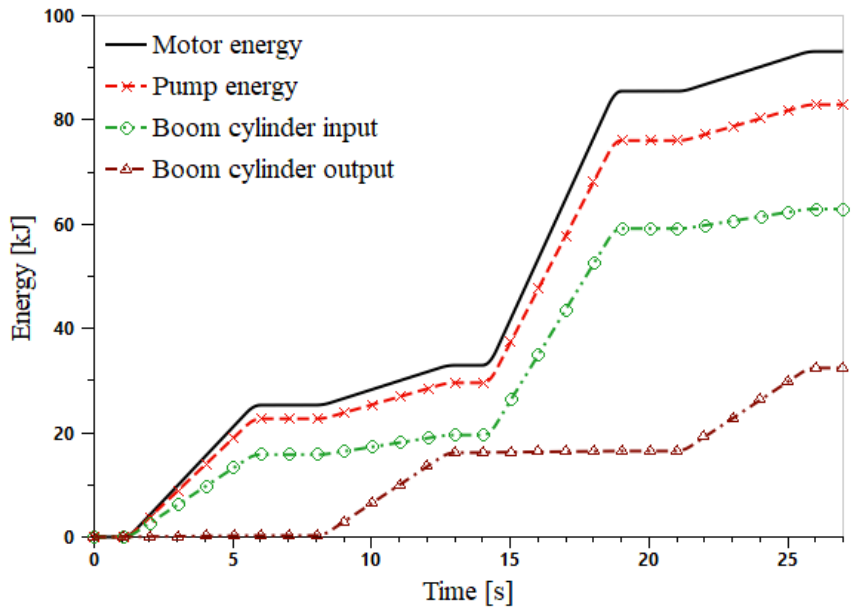
Figure 11. Energy consumption of the original system.